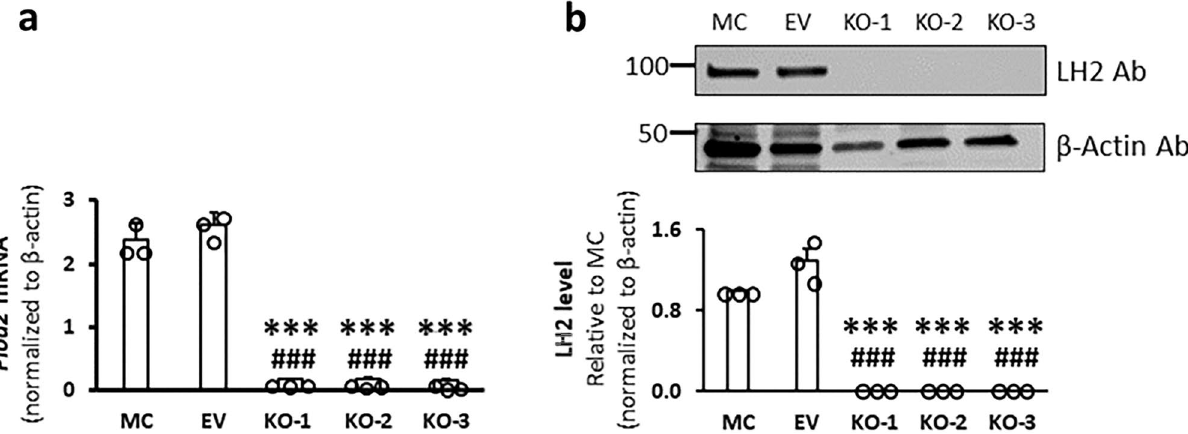
Figure 1. Gene expression of Plod2 (encoding LH2) and protein levels of LH2 in MC, EV, and KO clones. ( a ) The mRNA levels relative to the internal control ( Actb ) were assessed by quantitative real-time PCR (n = 3). ( b ) The protein levels of LH2 were assessed by their immunoreactivities with the antibody (Ab) relative to that of β-actin and were then shown as the change relative to LH2 expression levels in MC as 1.0. Values represent means ± S.D. (n = 3) from three independent experiments. Statistical differences were determined by Kruskal– Wallis one way analysis of variance and means comparison with controls by Dunnett’s method. *** p < 0.001 between MC and KO; ### p < 0.001 between EV and KO, respectively. Original blot is presented in Supplementary Fig. S3. LH lysyl hydroxylase, Plod procollagen-lysine, 2-oxoglutarate 5-dioxygenase, Actb beta-actin, Ab antibody, MC MC3T3-E1, EV empty vector, KO